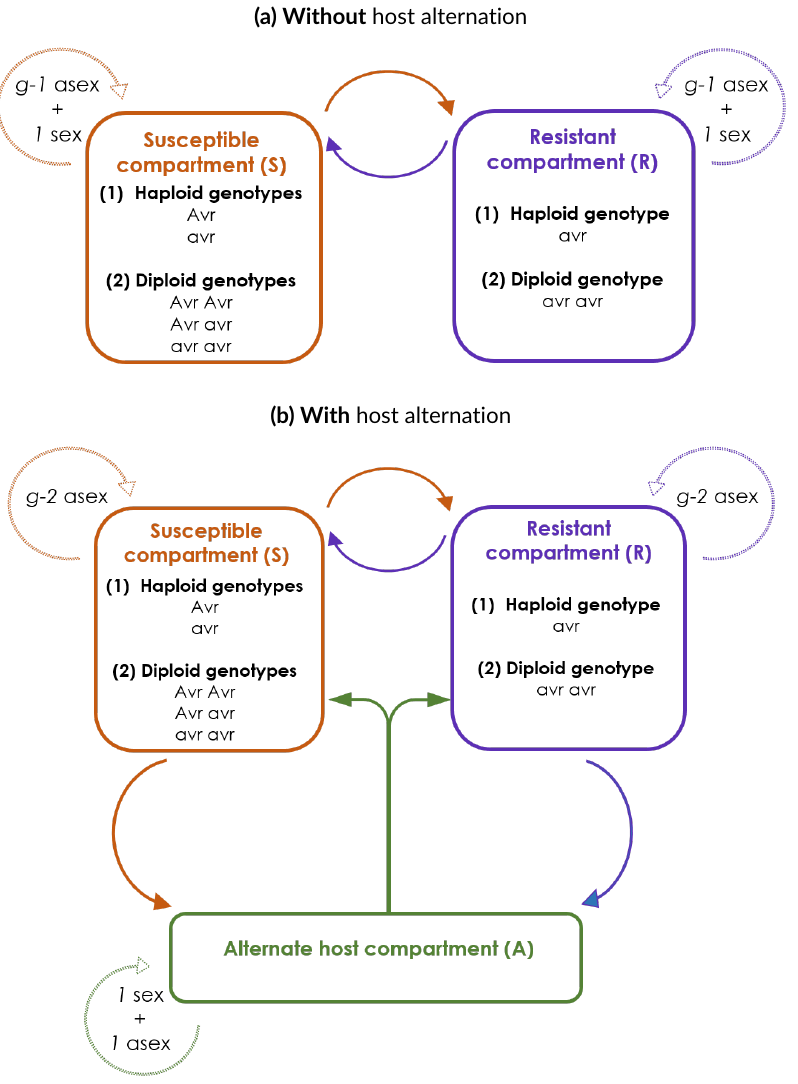
Figure 1 – Model representation for two different life cycles: (a) without or (b) with host alternation. g corresponds to the total number of generations (asexual plus sexual) in a year. Dashed arrows represent reproduction events, and solid arrows represent migration events occurring at each generation. asex stands for asexual reproduction events, and sex for sexual reproduction events. avr denotes the virulent recessive allele, and Avr the avirulent dominant